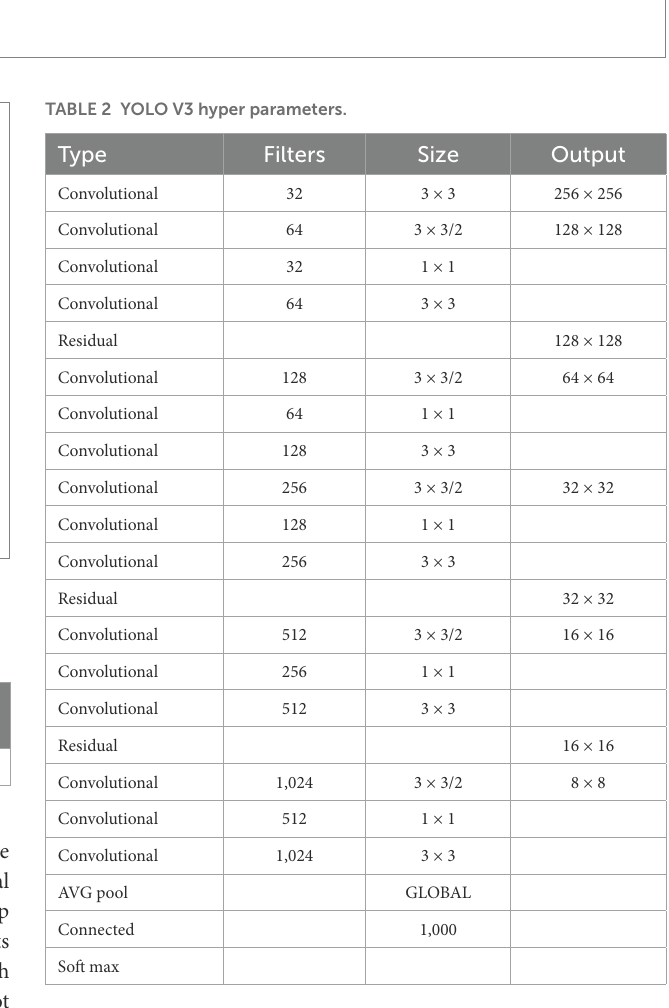
TABLE 2 YOLO V3 hyper